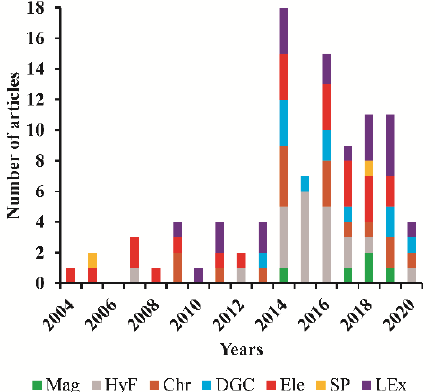
Figure 10. Timeline of separation methods: graphic representation of the number of published articles discriminated by separation method (separation methods: Mag—magnetic-based schemes; HyF—hydrodynamic forces; Chr—chromatography; DGC—density gradient centrifugation; Ele—electrophoresis; SP—selective precipitation; Lex—liquid extraction).